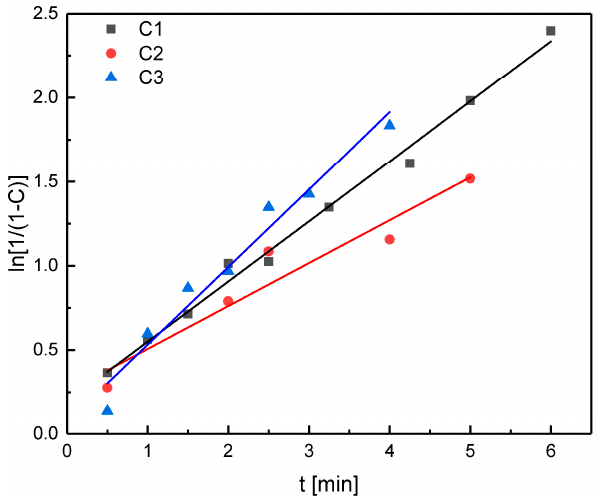
Figure 3. Semilogarithmic plot of the polymerization of technical rac -lactide [LA]:[catalyst] = 500:1, T = 150 °C, conversion determined via 1 H NMR spectroscopy. Table 5. Polymerization data from polymerization method a for complexes C1 – C3 after two